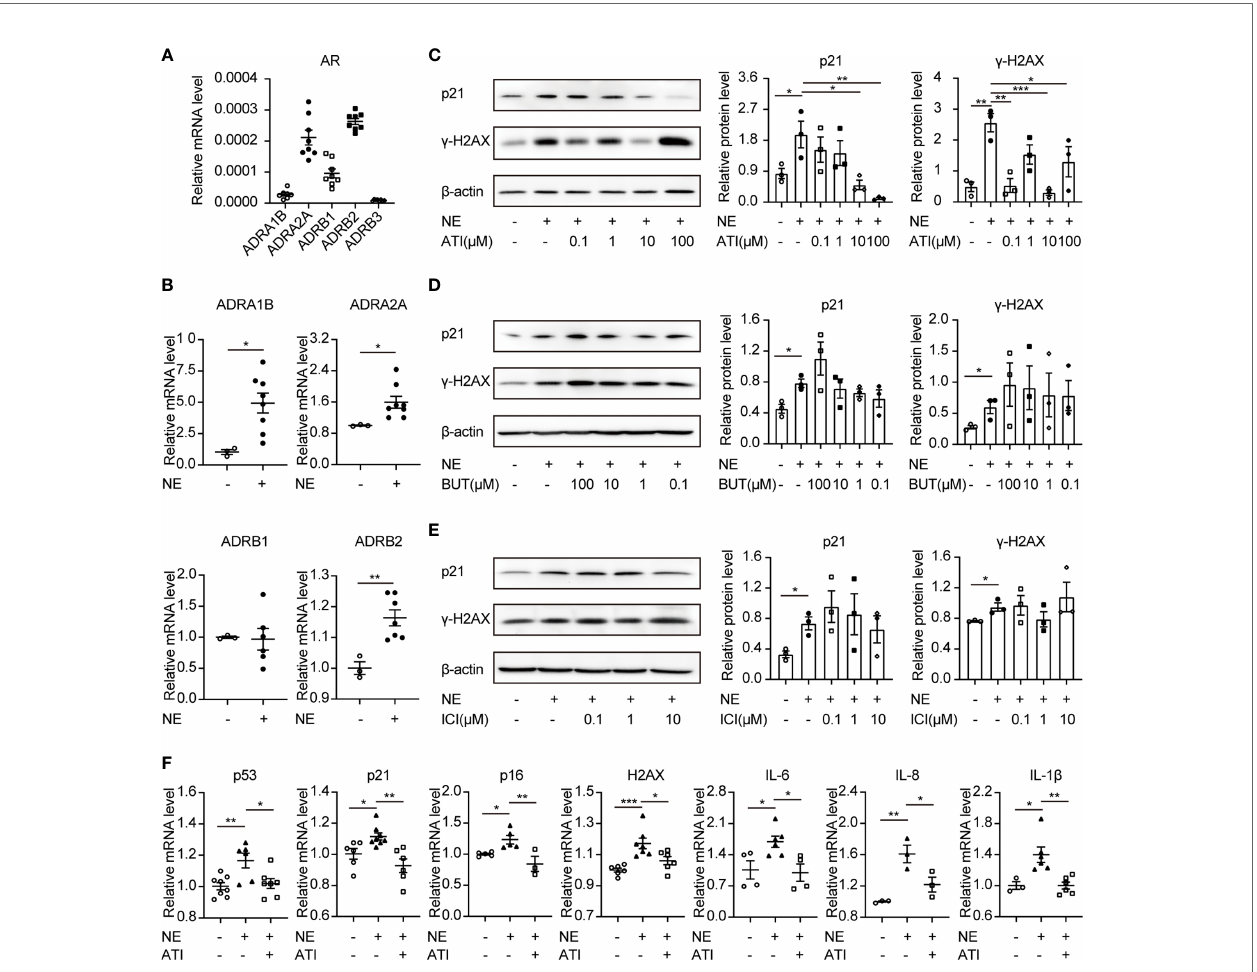
FIGURE 4 | Atipamezole ( a 2 -adrenergic antagonist) reverses cellular senescence induced by NE in renal tubular cells. TKPTS cells were incubated with NE (10 nM) for 48 hours after pretreatment with adrenergic antagonists or PBS for an hour. (A, B) mRNA expressions of ADRA1B, ADRA2A, ADRB1, ADRB2, and ADRB3 in PBS (control) or NE-treated TKPTS cells as shown by qRT-PCR analysis (n=3 – 8 in each group). (C) Representative Western blotting of p21 and g -H2AX in TKPTS cells treated with PBS, NE, and NE+ATI (Atipamezole, 100 nM, 1 m M, 10 m M, and 100 m M) with densitometry analysis (n=3 in each group). (D, E) Representative Western blotting of p21 and g -H2AX in TKPTS cells incubated with PBS, NE, and NE+BUT (Butoxamine)/ICI (ICI118551) (two b 2 -adrenergic antagonists, 100 m M, 10 m M, 1 m M, and 100 nM) with densitometry analysis, respectively (n=3 in each group). (F) mRNA expressions of p53, p21, p16, H2AX, IL-6, IL-8, and IL-1 b in TKPTS cells cultured with PBS, NE, and NE+ATI (10 m M) as displayed by qRT-PCR analysis (n=3 – 8 in each group). *P < 0.05, **P < 0.01, ***P < 0.001. Bars represented means ±